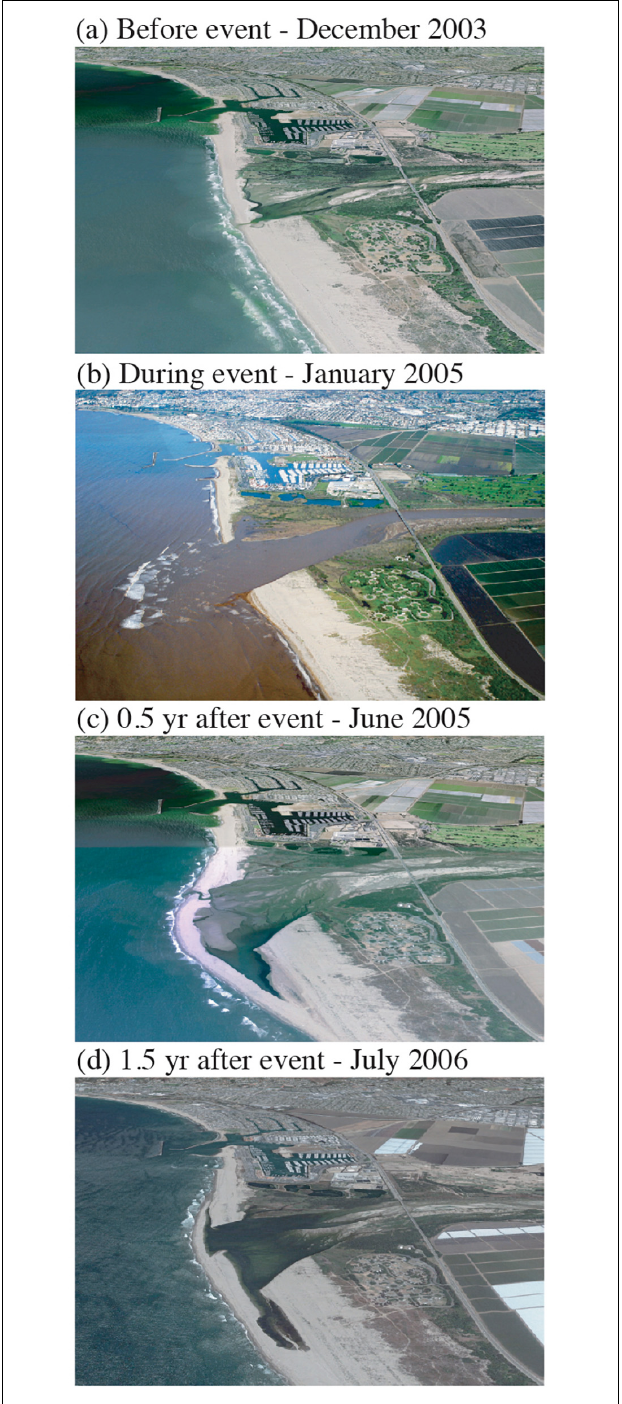
FIGURE 1 | Sediment discharge from the Santa Clara River and reworking of this sediment into river mouth bars as observed from oblique imagery. High flows on the river occurred in January 2005, which deposited sediment at least 500 m offshore of the river mouth as evidenced by breaking waves in panel (b) . This sediment was reworked toward the shore as shown during the following 1.5 years (c,d) . Imagery sources: (b) aerial photography by California Coastal Conservancy, (a,c,d) , Google Earth imagery rotated to the same orientation as the aerial photograph in panel (b) .